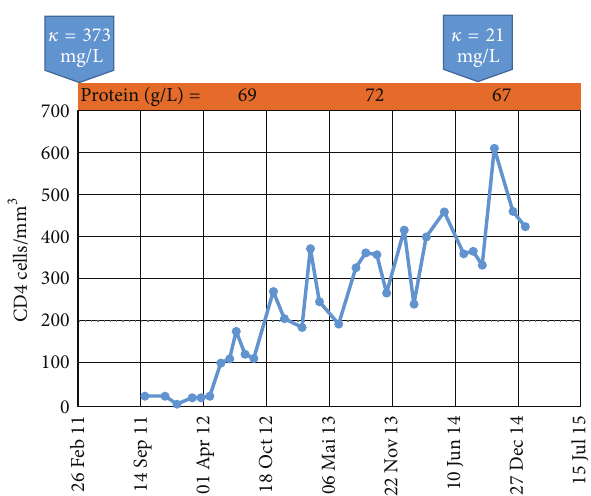
Figure 1: Evolution of CD4+ T cell count during and after bendamustine chemotherapy. Graph shows longitudinal evolution of CD4+ cell counts during and after bendamustine chemother- apy (from September 19, 2011, to February 29, 2012). 𝑦 -axis = CD4 cells/mm 3 ; 𝑥 -axis = date. (Top) orange box show plasma protein quantitation